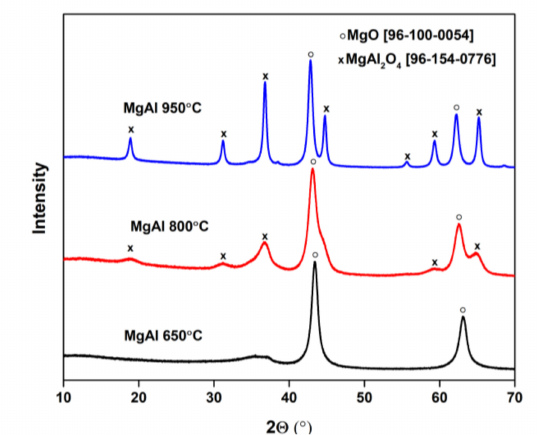
Figure 6. XRD patterns of mixed metal oxides (MMO) obtained by heating the Mg 2 / Al 1 LDHs at di ff erent